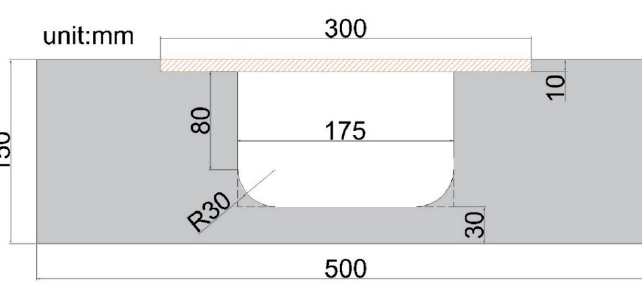
Figure 7. The geometry of designed strut-and-tie beam specimen.